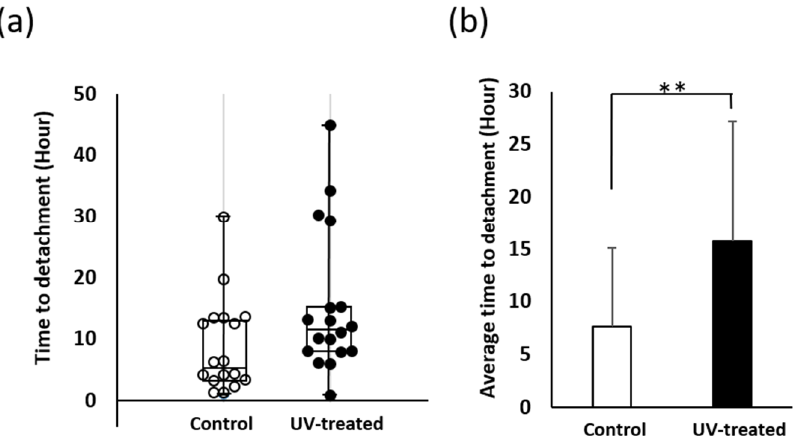
Figure 2. Time to detachment of mucosa connective tissues from titanium surfaces. ( a ) Box-and- whisker plots showing the distribution of time to detachment of tissue sections with and without UV treatment. ( b ) Comparison of average time to detachment of tissue sections with and without UV treatment. Data are mean ± SD ( n = 18). ** p < 0.01, statistically significant difference between the control and UV-treated surfaces.